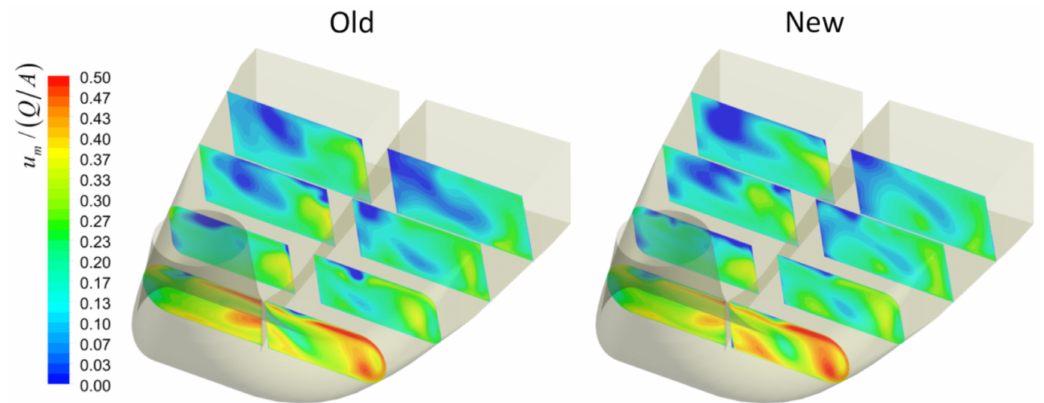
Figure 22. Flow velocity in the draft tube of old and new geometries of case 2 functions of the inlet area of the draft tube and the turbine